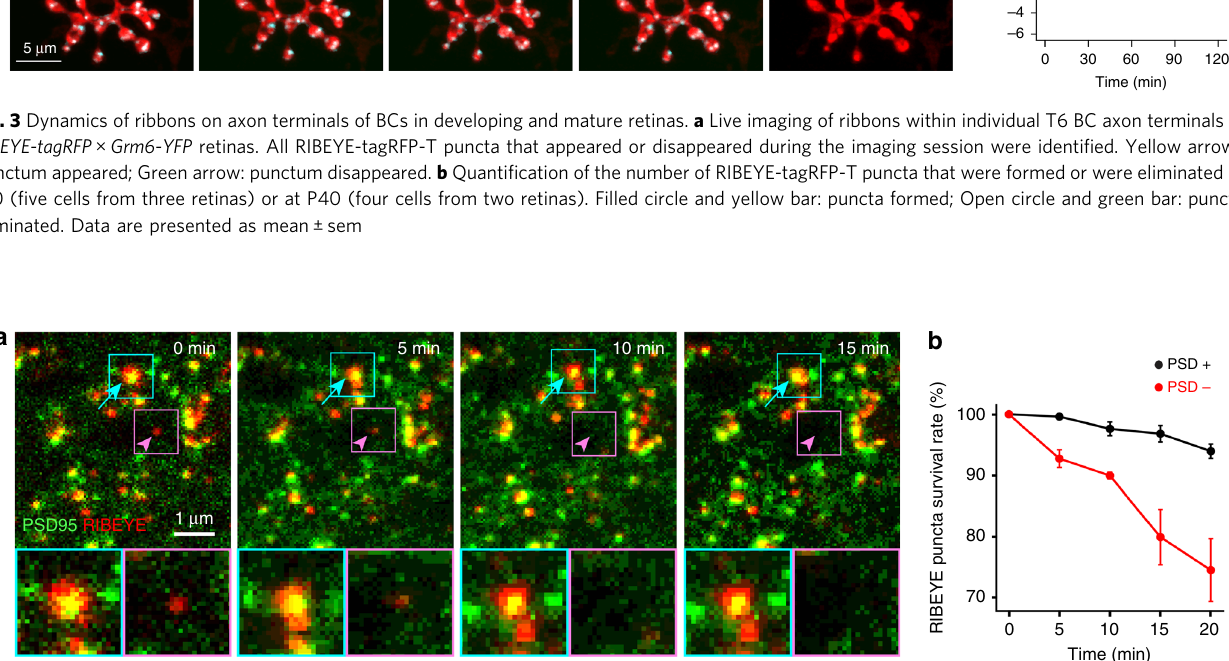
puncta were formed at sites without a ribbon in the P40 retinas (Fig. 5c; fi ve cells from 4 P10 retinas and four cells from 2 P40 retinas, Mann – Whitney rank sum test: p = 0.421 for P10 and p = 0.036 for P40). At both ages, PSD95 puncta were, however, relatively more stable when apposed to ribbons (Fig. 5d).